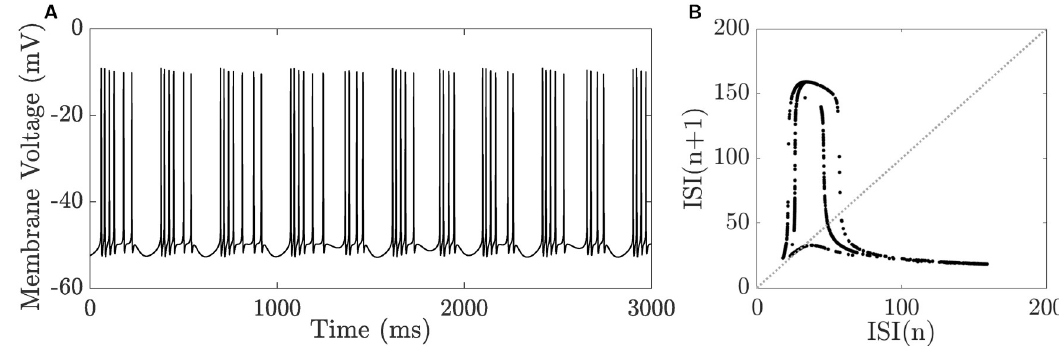
Fig 14. Chaotic bursting in the CSC model defined by the full system (1). A ) Time course of the membrane voltage V when exhibiting chaotic bursting obtained by setting g K(Ca) = 3 μ S.cm − 2 and g HVA = 0.215 μ S.cm − 2 . B ) The return map of the interspike interval (ISI) for the time course of V in A .